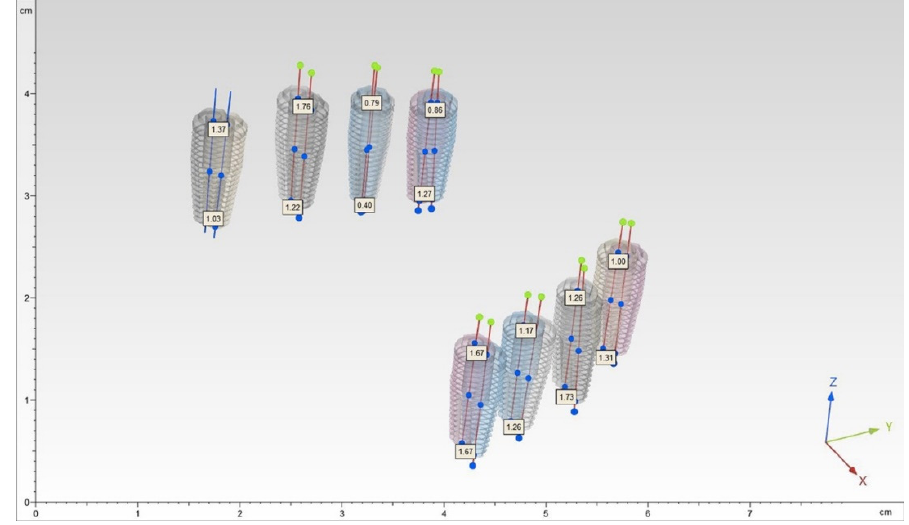
Figure 4. Superimposition of the preoperative and postoperative CBCTs and measurements of the deviations between the planned and the placed implants.